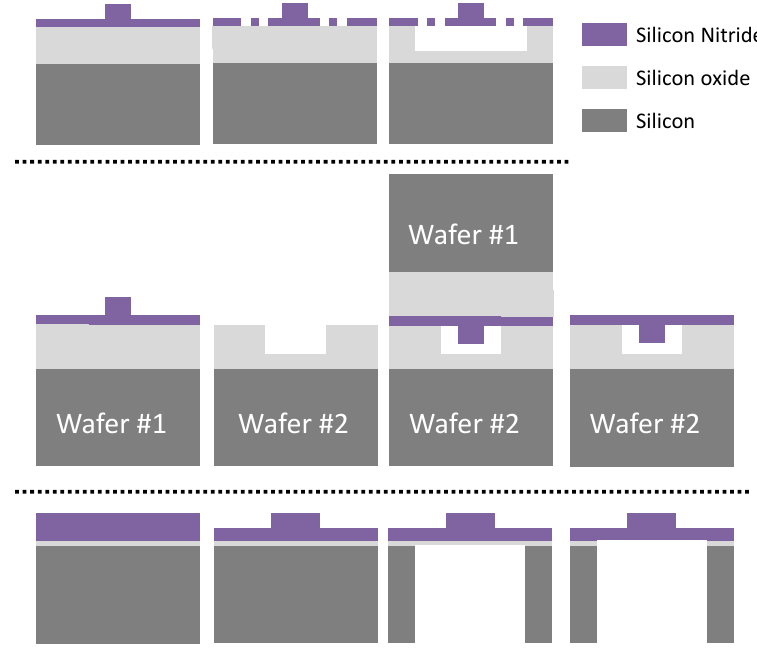
Figure 11. Processes to turn the Si 3 N 4 platform into a membrane waveguide platform: through Si 3 N 4 under-etch of the SiO 2 ( top ); two wafer process using flip and bond ( middle ); two side etch process using a single wafer ( bottom)